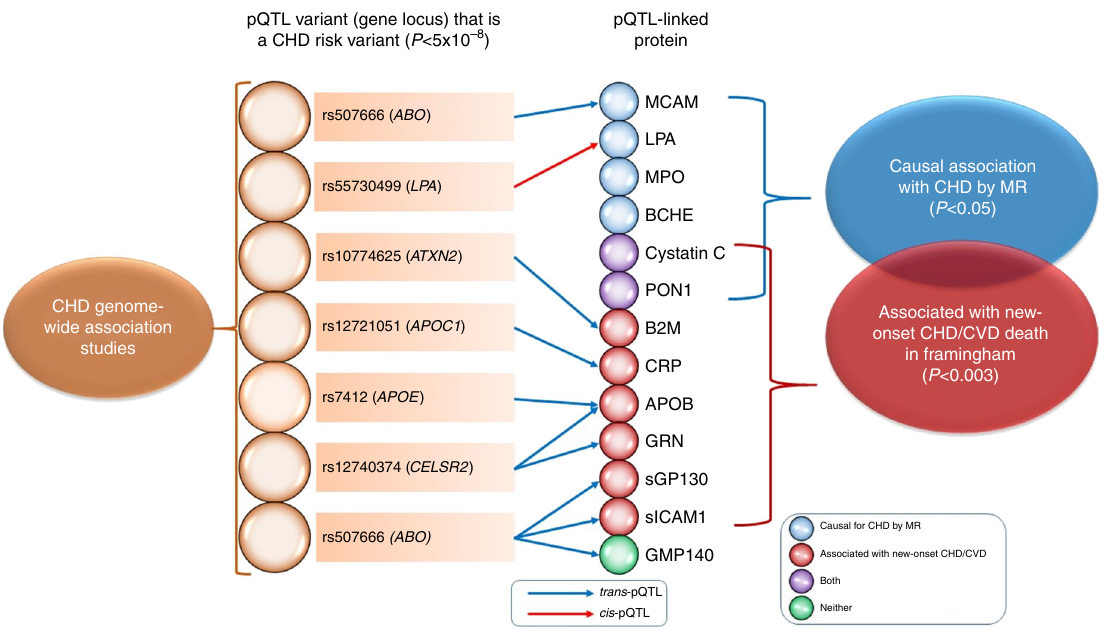
Fig. 4 pQTL-protein-coronary heart disease network. Network of proteins and signi fi cant pQTL variants that are also GWAS risk SNPs for CHD. For proteins with multiple pQTL variants that coincide with CHD GWAS SNPs, the pQTL variant with the lowest P value of association with its corresponding protein level is shown. The following two conditions are summarized: (1) Proteins that tested causal for CHD in Mendelian randomization ( P < 0.05). (2) Proteins associated with new-onset major CHD/CVD events ( P < 0.0038) in 3520 Framingham Heart Study participants 50 years of age or older with long-term follow-up. Proteins in green ful fi ll neither condition 1 nor 2; proteins in blue ful fi ll condition 1; proteins in red ful fi ll condition 2; proteins in purple ful fi ll conditions 1 and 2. CHD coronary heart disease, FHS Framingham Heart Study, MR Mendelian randomization, pQTL protein quantitative trait